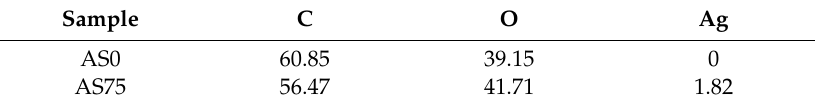
Figure 6. The cross-sectional morphology of hydrogels are ( A ) AS0, ( B ) AS25, ( C ) AS50, and ( D ) AS75; EDS (Energy Dispersive Spectrometer) element analysis of hydrogels are ( E ) AS0 and ( F ) Table 2. Analysis of the content of elements in hydrogel by AS75. Table 2. Analysis of the content of elements in hydrogel by EDS.